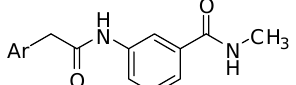
Figure 2. The chemical structures of the target α -anilinoketone, 2-anilinoalcohol, α -anilinoamides and α -anilinoester